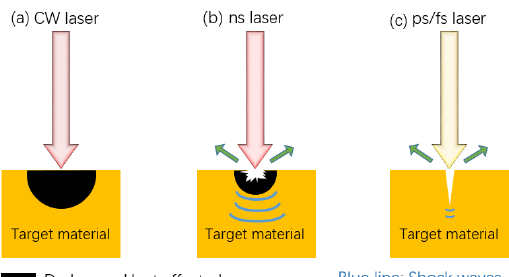
Figure 12. Differences of three types of laser fabricating: ( a ) continuous laser, ( b ) nanosecond laser, and ( c ) picosecond, femtosecond laser.